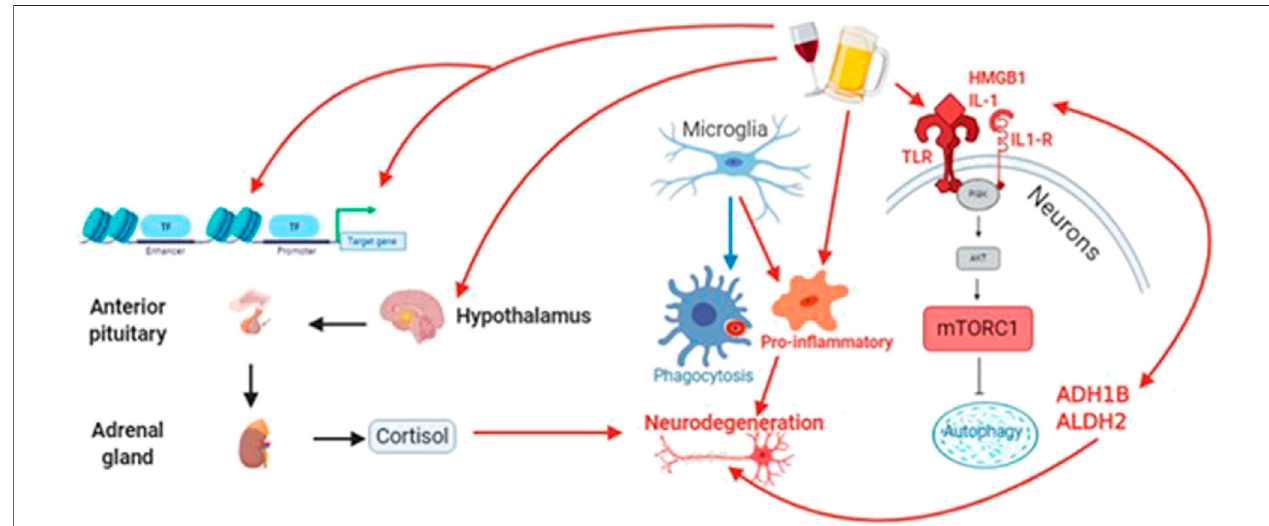
FIGURE 4 | Alcohol acts through diverse signaling pathways, including oxidative stress, to increase neuroin fl ammation and reduce both autophagic and cytophagic clearance of toxic protein species that contribute to neurodegeneration. At the same time, alcohol alters the expression and activity of epigenetic proteins (e.g., methyltransferases/demethylases and DNA acetylases/deacetylases. Finally, alcohol drives an unhealthy stress response through the hypothalamic-pituitary- adrenal (HPA) axis, leading to long-term increases in circulating